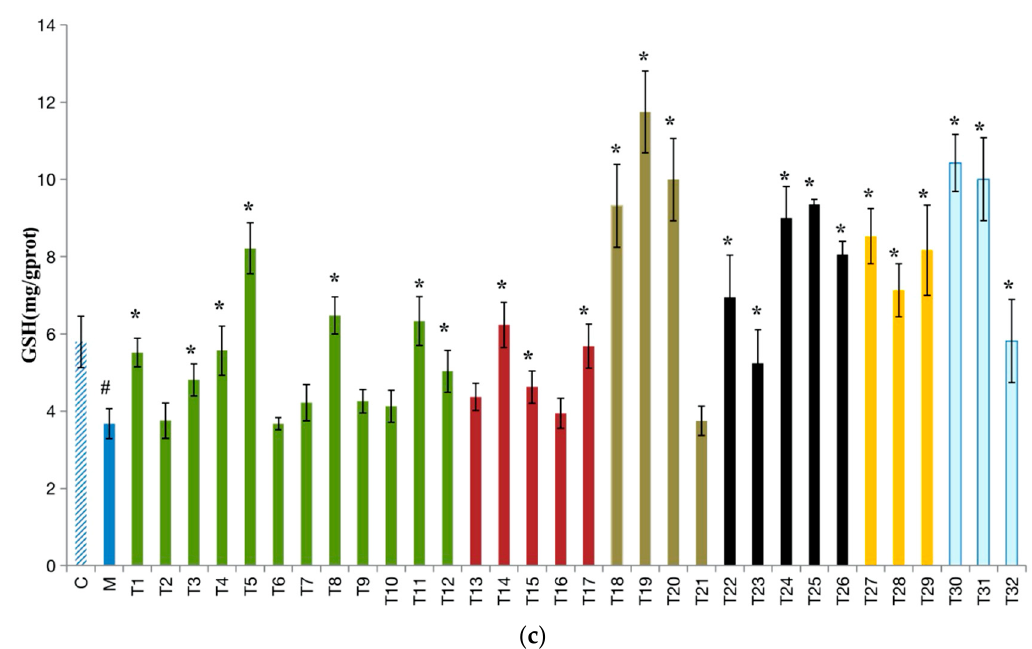
Figure 3. The e ff ects of 32 teas on liver ( a ) superoxide dismutase (SOD); ( b ) glutathione peroxidase (GPx); ( c ) glutathione (GSH) levels. # p < 0.05, the model group versus the control group. * p < 0.05, the treatment group versus the model group. C, the control group; M, the model group; T1, Chaoqing Green Tea; T2, selenium-enriched Chaoqing Green Tea; T3, Enshi Yulu Tea; T4,